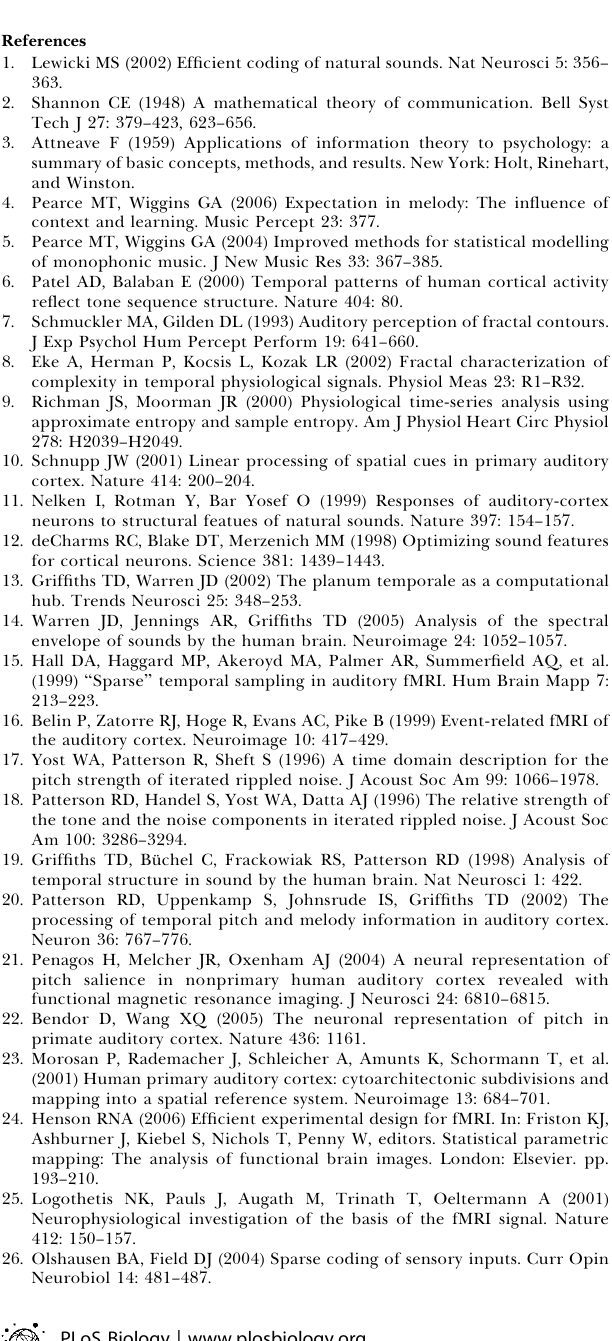
Table S1. MNI Coordinates for Retrieval and Comparison Local maxima coordinates for the main effect of retrieval and comparison (contrast: [second scan–first scan]) at p , 0.05 (FWE corrected for multiple comparisons across the brain). IPS, intra- parietal sulcus; mSFG, medial superior frontal gyrus; VLPFC, ventrolateral prefrontal cortex; IFG, inferior frontal gyrus. Table S2. Pitch Sequence Classification Descriptive data for the pitch sequences in the two studies with a classification scheme based on the sample entropy estimates. (See also Text